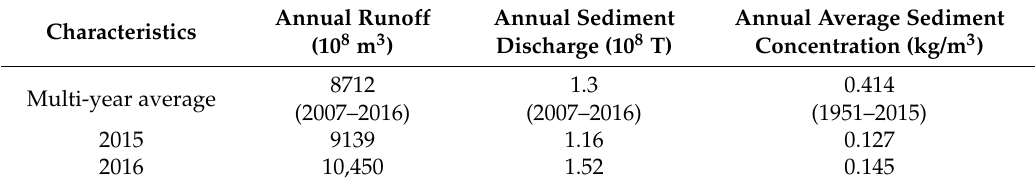
Table 3. Interannual comparison of water and sediment characteristic of Datong hydrological station.